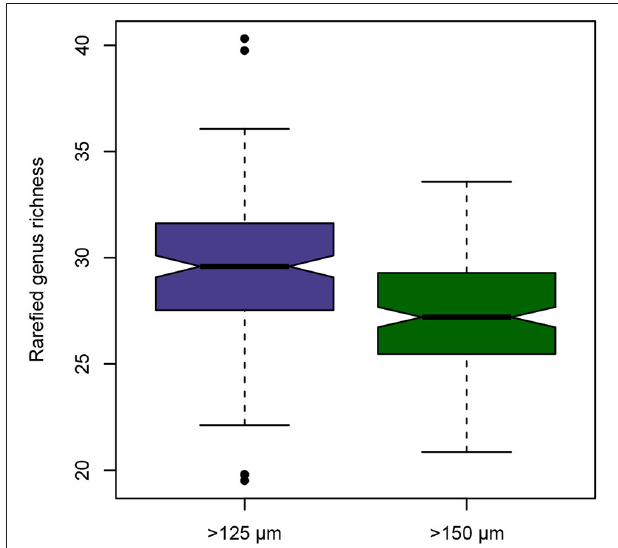
FIGURE 1 | Notched boxplot depicting the differences in observed rarefied genus richness of benthic foraminiferal assemblages between the >125 and >150µm size fraction from the Pefka E section. Horizontal line depicts median, boxes indicate interquartile range (IQR), whiskers extend to 1.5 × IQR, outliers are marked by black